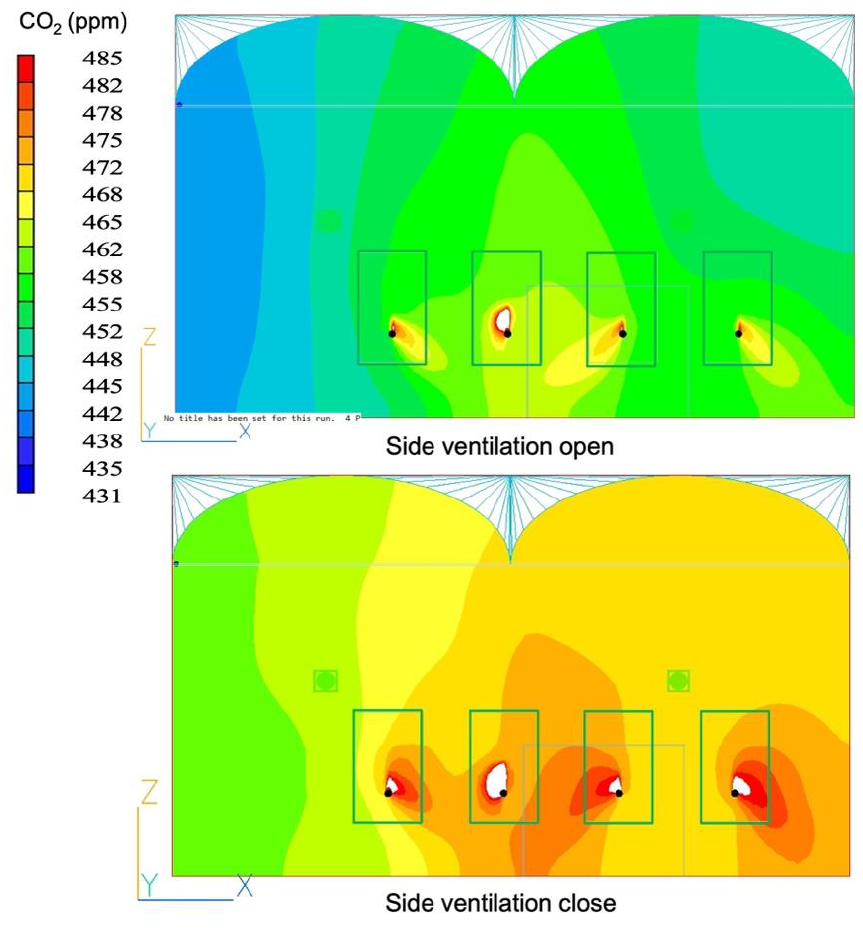
Figure 12. The CO 2 distribution inside of the greenhouse in case the side ventilations open and closed (image taken at cross-section 6 m from south wall). Table 5. Coefficient of variations of CO 2 concentration in the case of side vents open and closed.